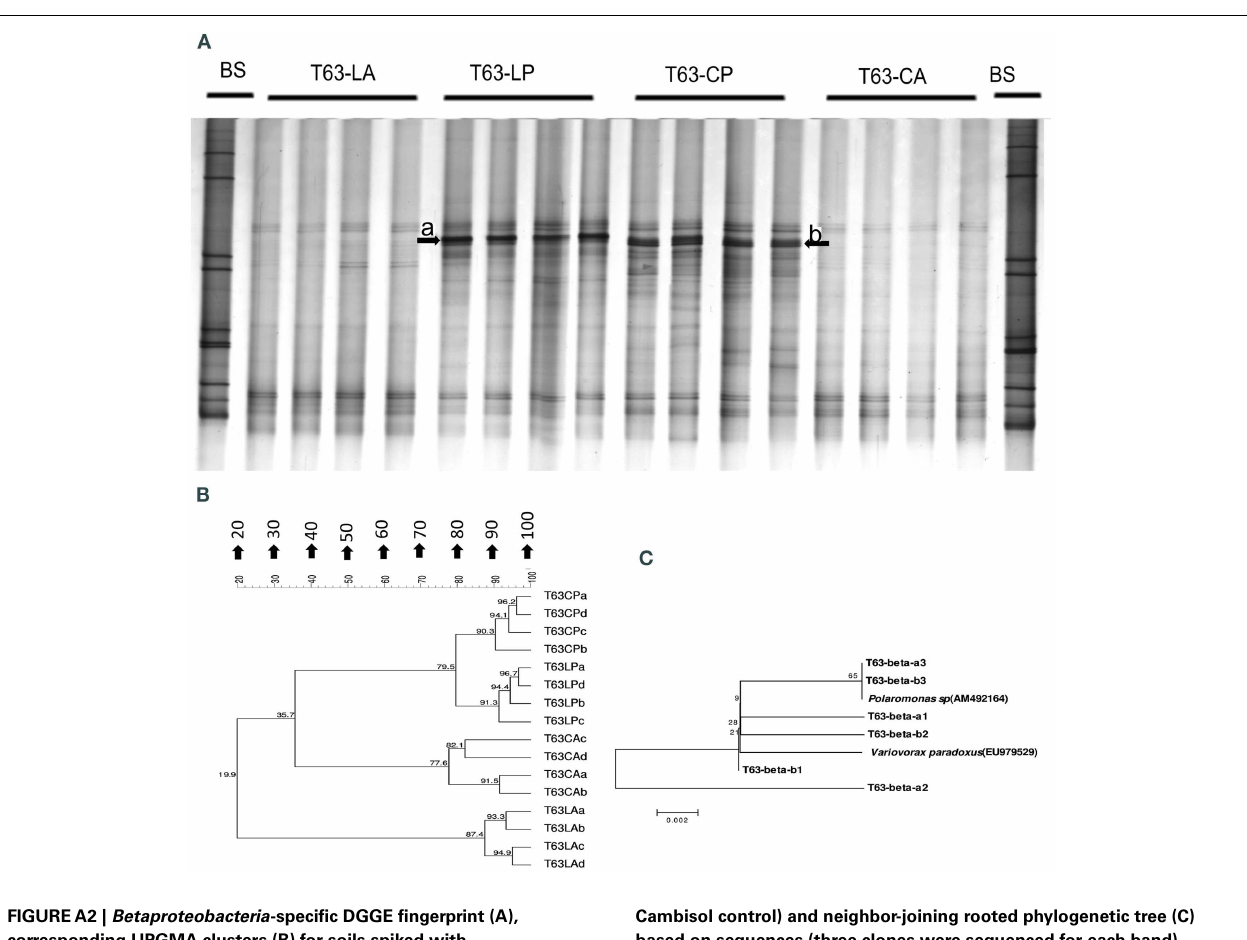
Cambisol control) and neighbor-joining rooted phylogenetic tree (C) based on sequences (three clones were sequenced for each band)